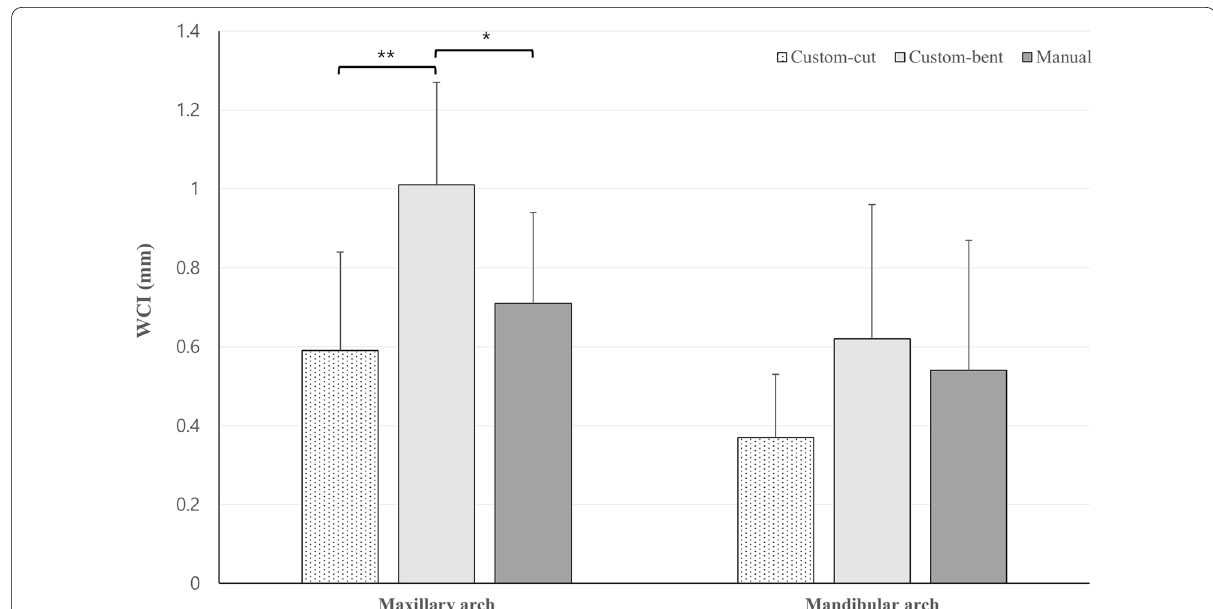
Fig. 8 Comparison of WCI between three groups in maxillary and mandibular arch. * significance at the 0.05 level. ** significance at the 0.01 level